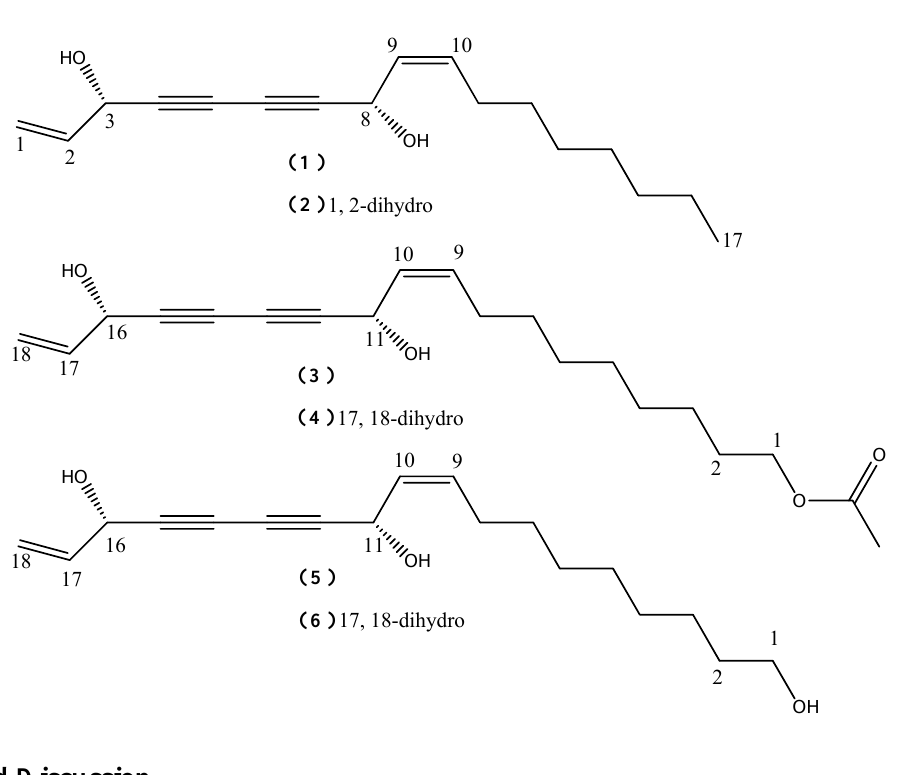
Figure 1. Structures of compounds 1 - 6